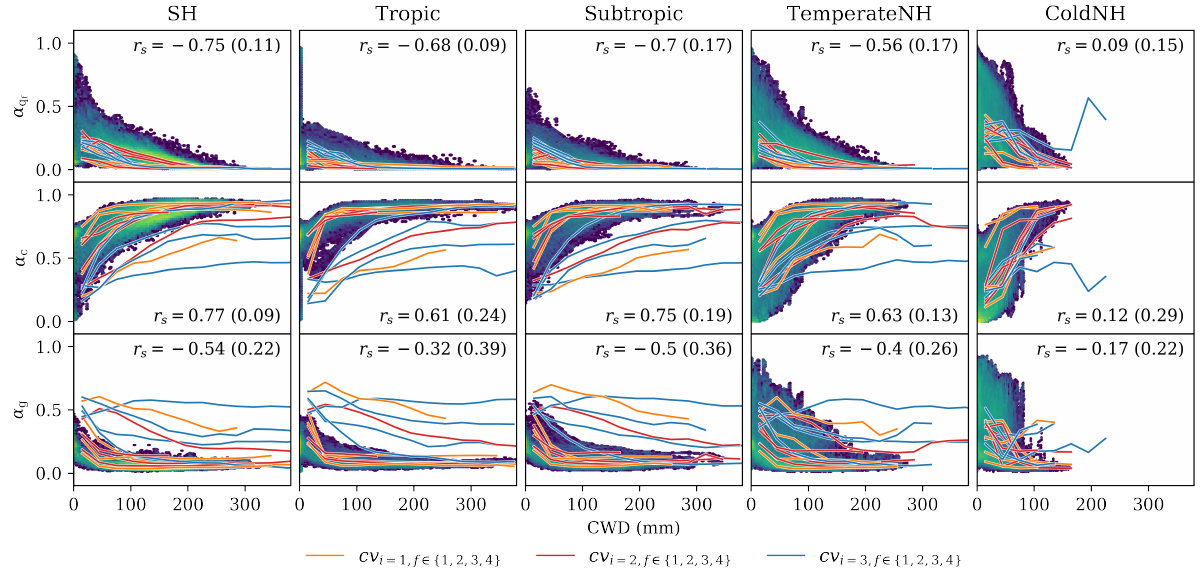
Figure 4. Regional mean time series of repeated model simulations of total water storage (TWS) and the latent variables groundwater (GW), soil cumulative water deficit (CWD), fast runoff (Q f ), and ET partitioning fraction ( α e ), defining to what share evapotranspiration is extract form the soil versus groundwater. The lines represent the mean value of a single cross-validation test set. The lines are colored by cross-validation run index, i.e. , lines with the same color come from one cross-validation run and represent the same grid-cells. The repeated runs give an impression of the model robustness.